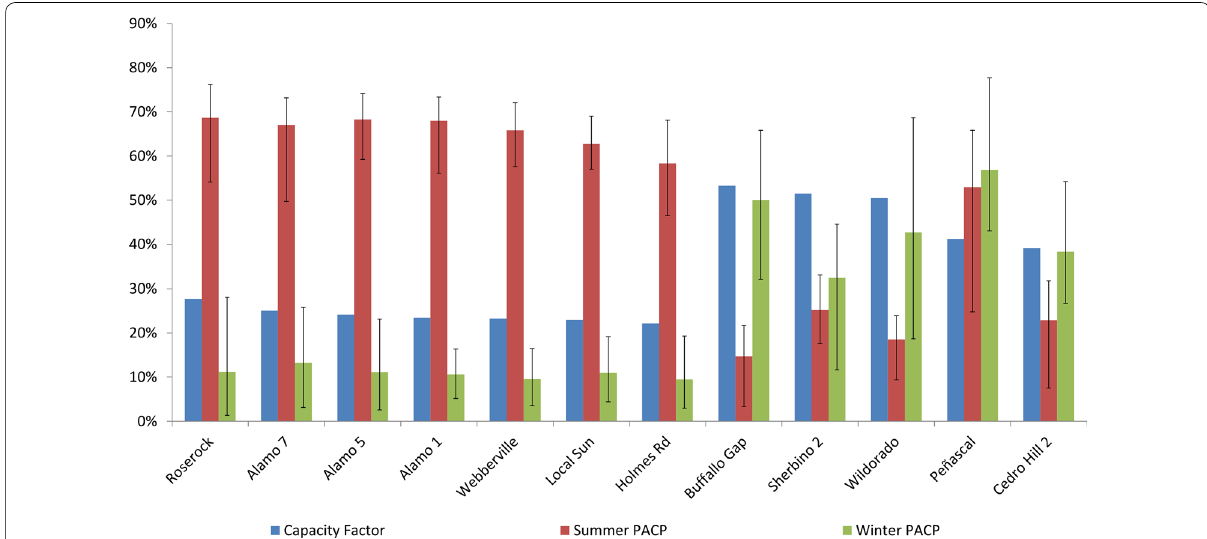
Fig. 2 Solar and wind farm capacity factors overall, and during summer and winter peak hours, averaged over 2007–2013. Error bars show the range of annual